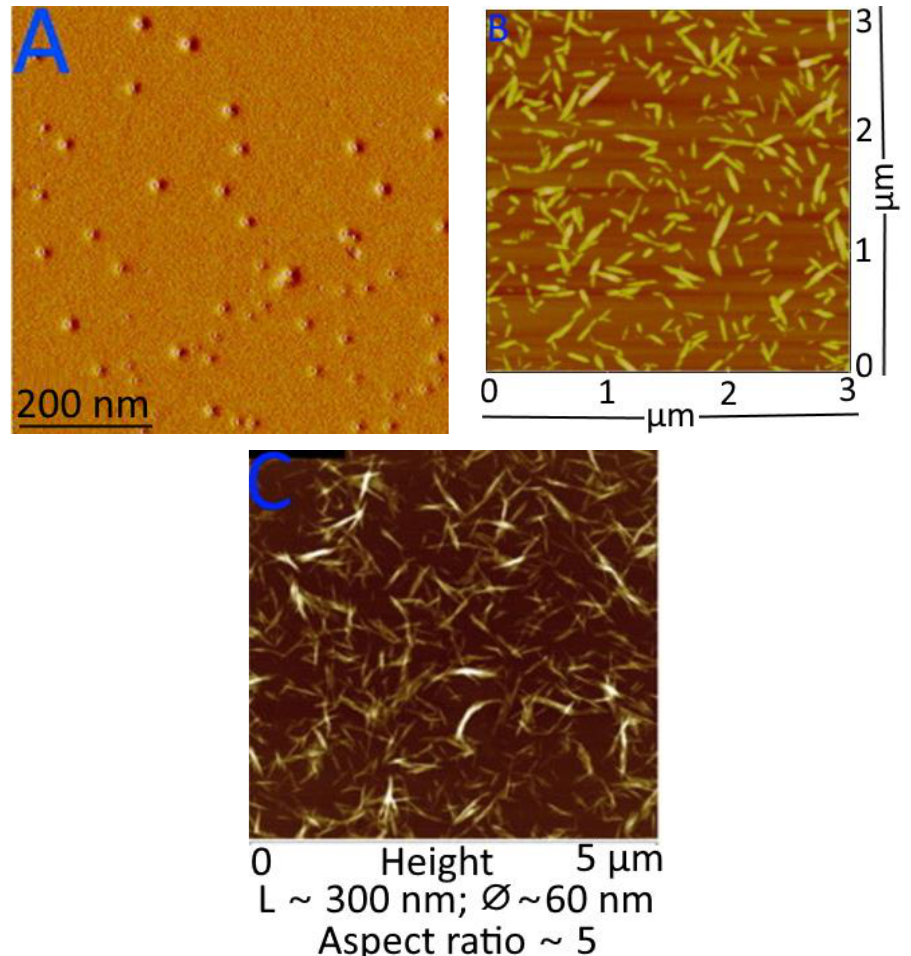
Figure 8. AFM images of ( A ) starch nanocrystals, ( B ) cellulose nanocrystals, and ( C ) chitin nano- whiskers. Figure 8A–C reprinted with permission (copyright © 2023, 2013, and 2014, Elsevier Ltd., whiskers. Figure 8A – C reprinted with permission (copyright © 2023, 2013, and 2014, Elsevier Ltd., Amsterdam, The Netherlands) from Espino-P é rez et al. [239], Liu et al. [240], and Salaberria et al. Amsterdam, the Netherlands) from Espino-Pérez et al. [239], Liu et al. [240], and Salaberria et al. [241].